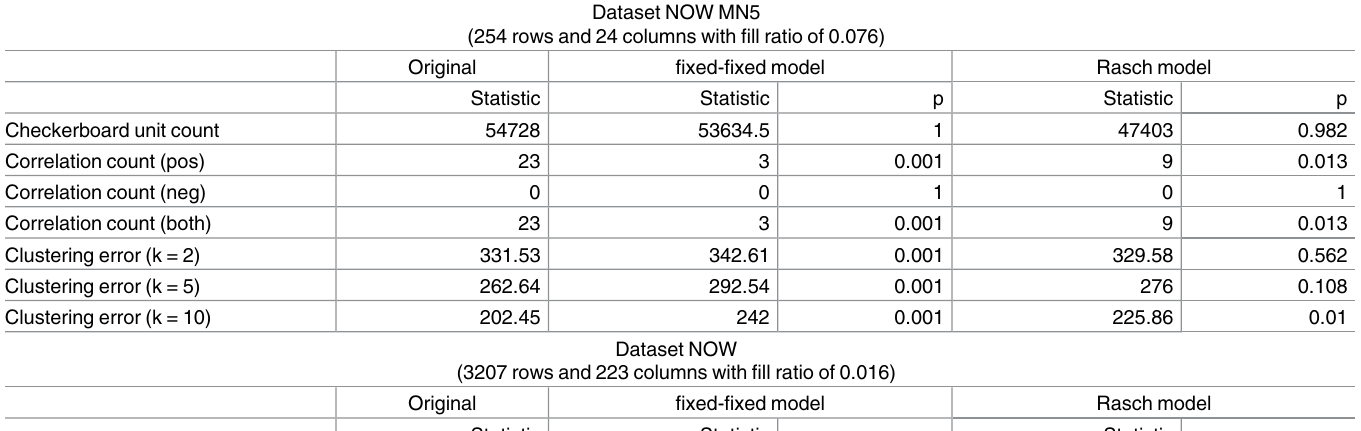
Table 2. Statistics for original datasets and randomized datasets with both the fixed-fixed null model and Rasch null model. Median statistic over all randomizations is reported for randomized data. p -values are defined as the empirical probability of observingstatistic at least as extreme from the ran- domized data. For each dataset dimensions are given together with the fill ratio, i.e., the ratio of matrix cells with value 1. Dataset NOW MN5 (254 rows and 24 columns with fill ratio of